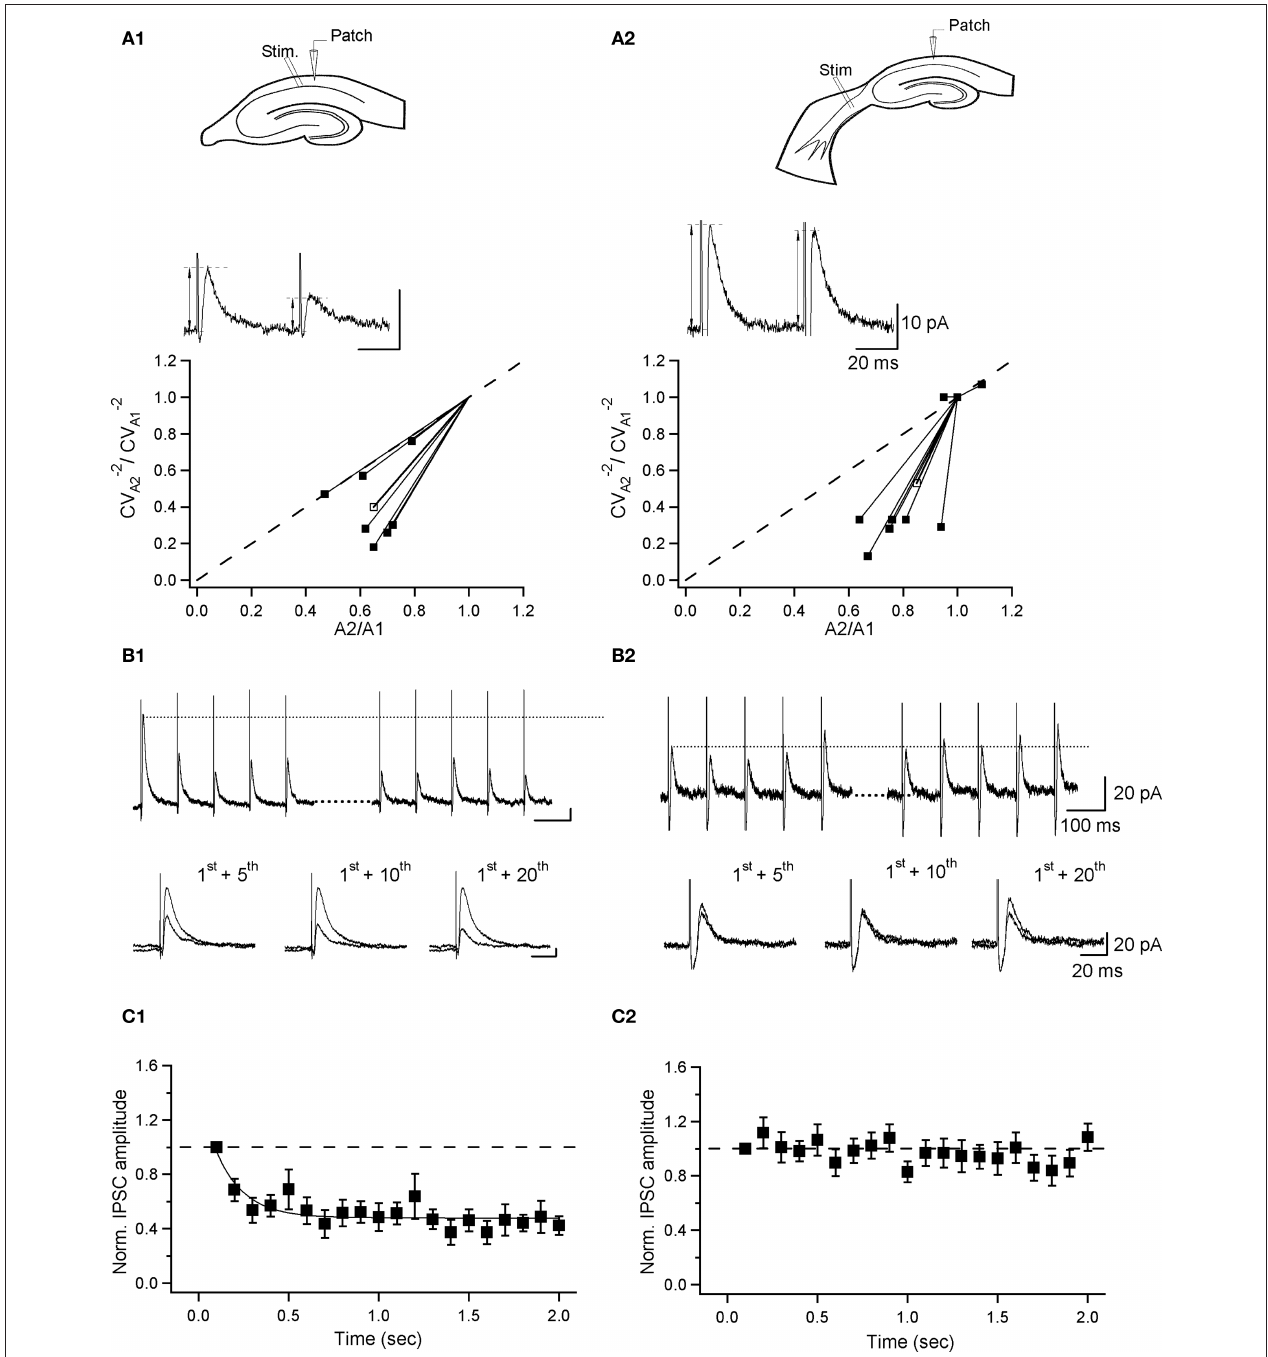
FiGure 5 | Distinct dynamics of inhibition at local and septohippocampal synapses. (A) Schematic of the recording and stimulation configuration in hippocampal (A1) and septohippocampal (A2) slices (top) and sample traces of eIPSCs (average of 10 sweeps; failures excluded) evoked by paired-pulse stimulation at local (A1) and SH (A2) synapses together with summary plots (bottom), showing the coefficient-of-variation analysis of paired-pulse depression of eIPSCs at two synapses. The inverse of the square of the coefficient of variation of the second response (CV A22 − ) was plotted versus the mean peak amplitude; data were normalized by the CV 12 − and the mean of the first response, respectively. Thick lines with open symbols correspond to the average values.